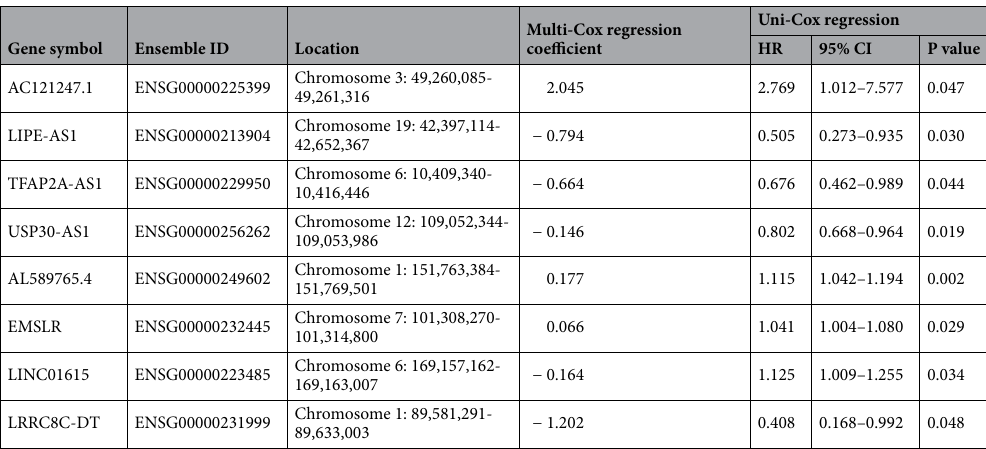
Table 2. 8 mitochondrial function-related lncRNAs of the prognostic